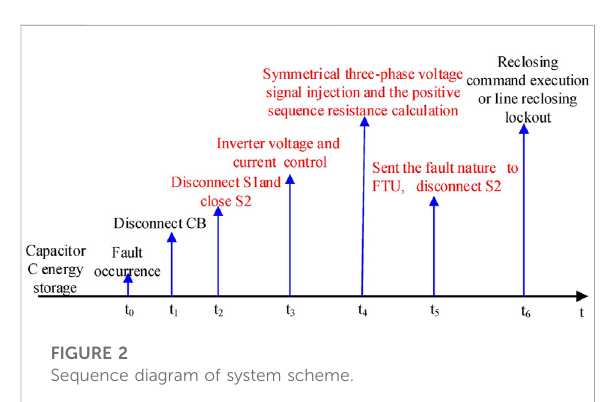
FIGURE 2 Sequence diagram of system